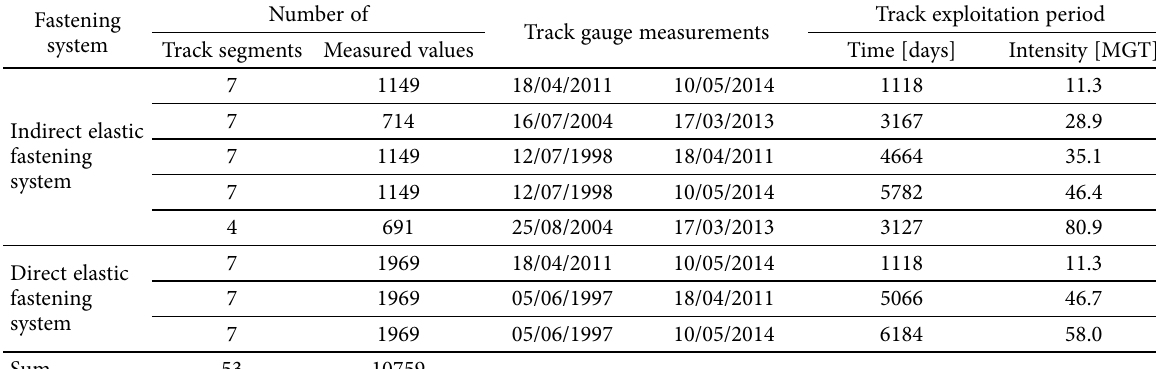
Table 1. Calculated exploitation periods for observed track segments Fastening